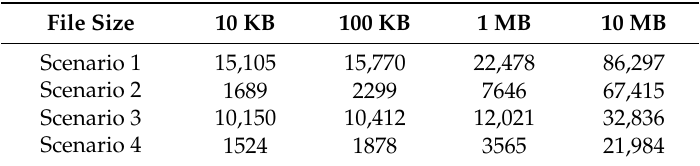
Table 4. Total data processing and transmission times on the Intel processor ( µ s) when the CAN-SEAT strategy is forced to be